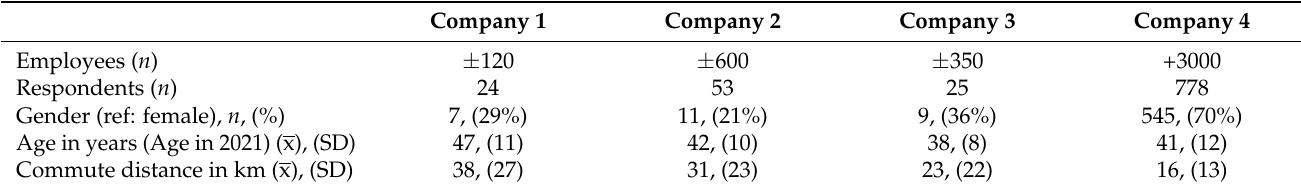
Table 1. Descriptives of respondents.